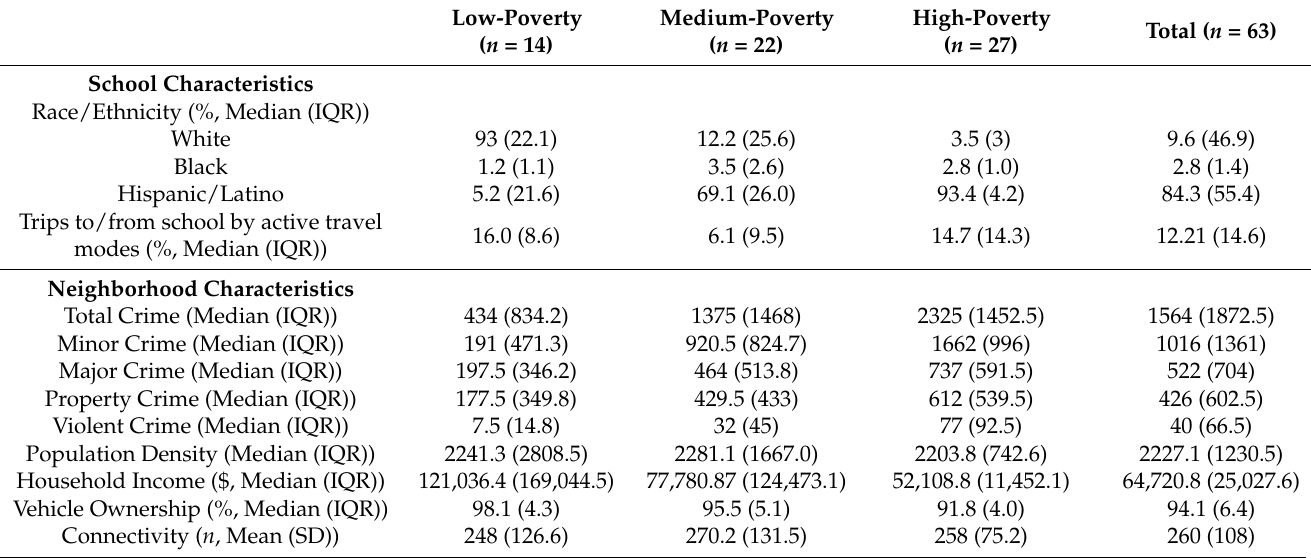
Table 1. School- and Neighborhood- Level Descriptive Characteristics by School Poverty